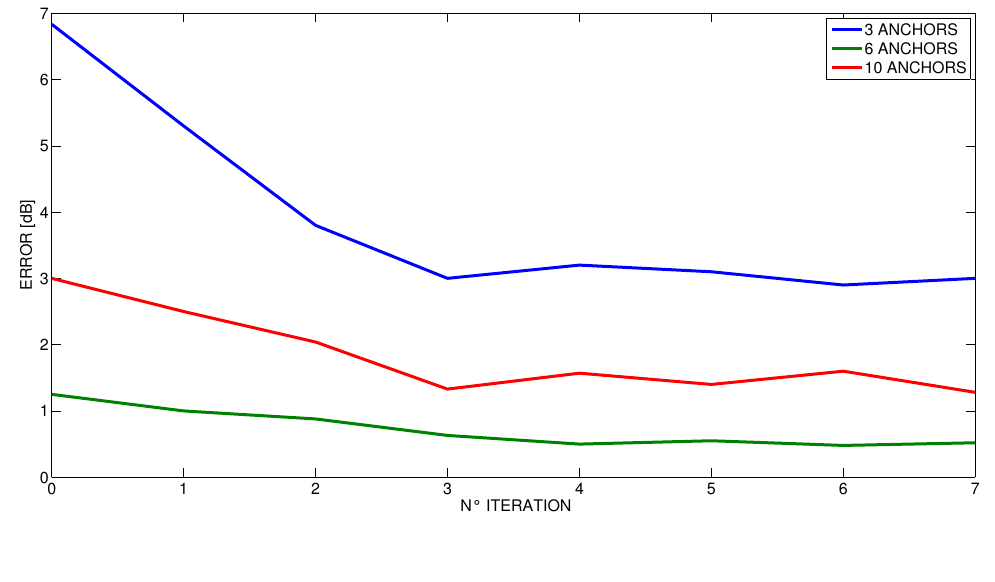
Figure 15. Decrease of error by method iteration in the office.